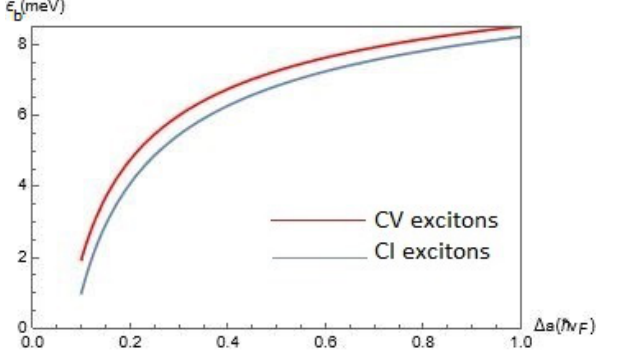
Figure 2. The exciton binding energy E b ( α , ∆ , D ) for CV and CI excitons as functions of the gap ∆ for chosen parameter α = 0.6 and interlayer separations D = 25 nm. The lattice constant of α − T 3 is a = 2.46